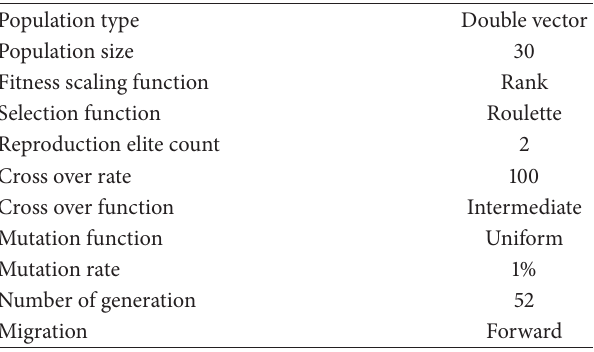
Table 11: For GA